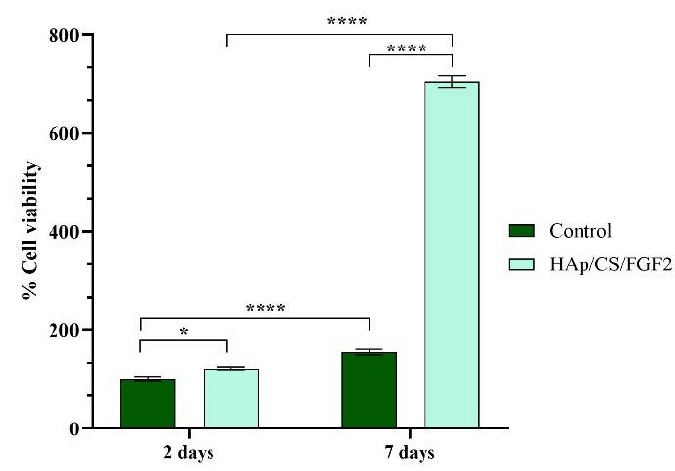
Figure 5. Graphical representation of MC3T3-E1 cell viability and proliferation potential after 2 days and 7 days of contact with control and HAp/CS/FGF2 samples (* p < 0.05; **** p < 0.0001).